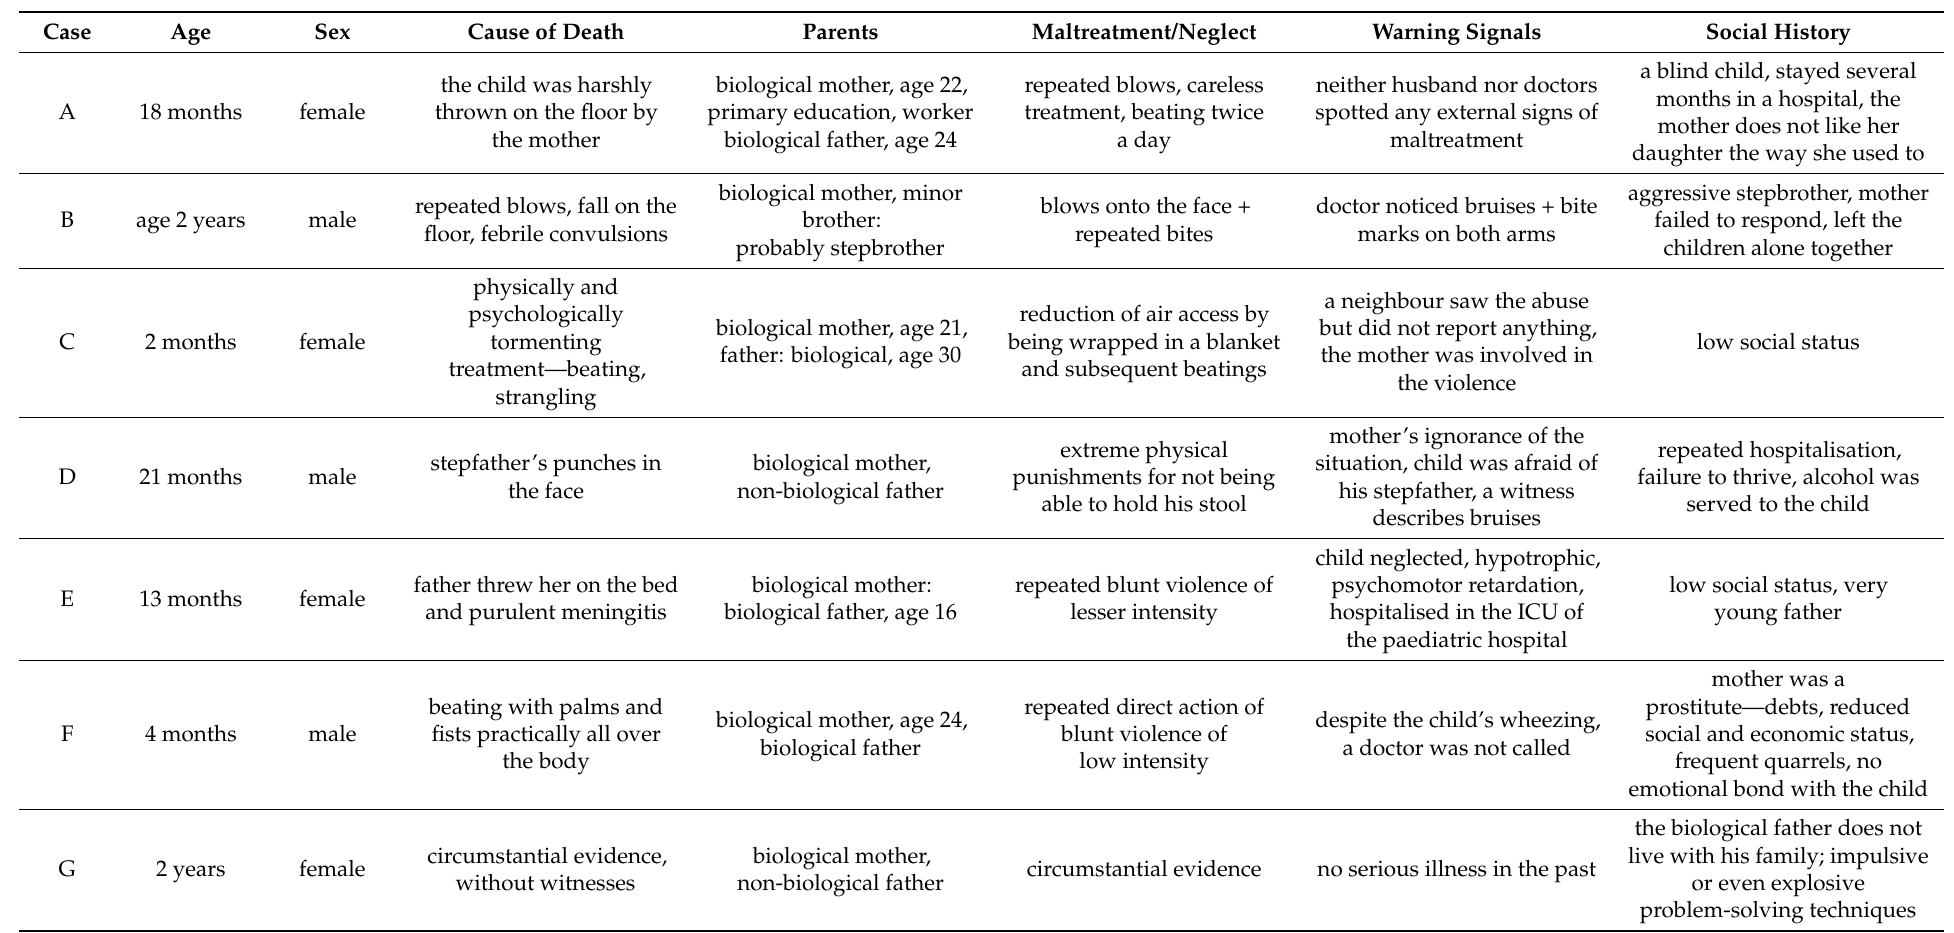
Table 2. Serial case study—social demographic